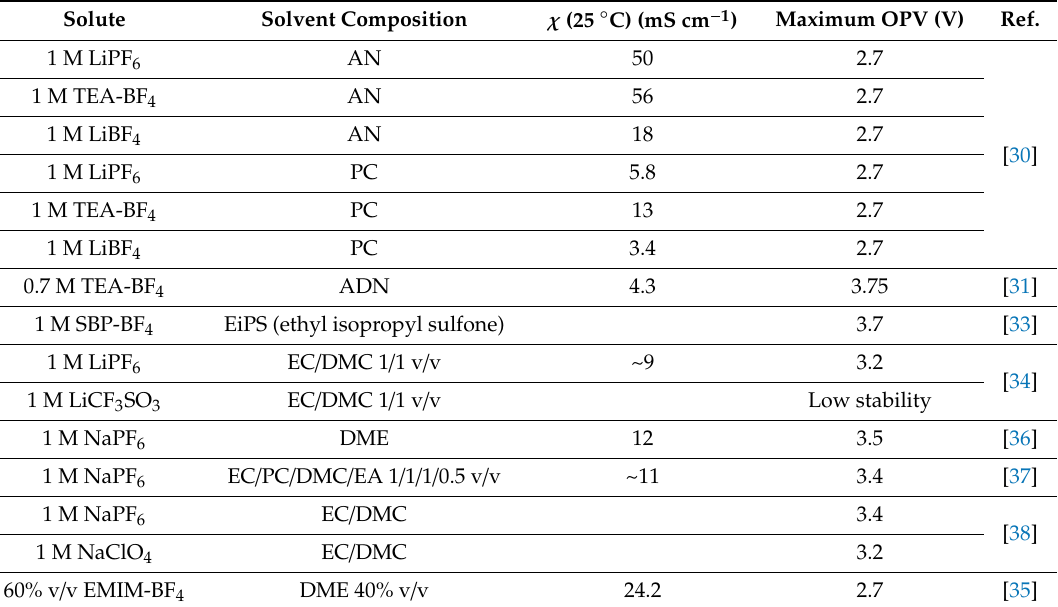
Table 2. Reported organic solvent-based electrolytes for the